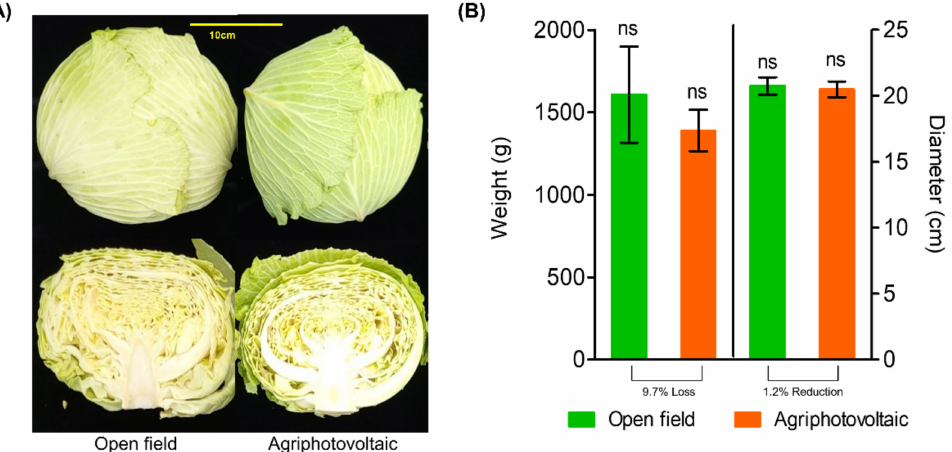
Figure 2. Pictures of cabbages ( A ); weight and diameter of cabbages grown under open-field (OF) and agriphotovoltaic (APV) conditions ( B ). Each parameter was measured immediately after harvesting ( n = 4). The graph has a scale bar of 10 cm;